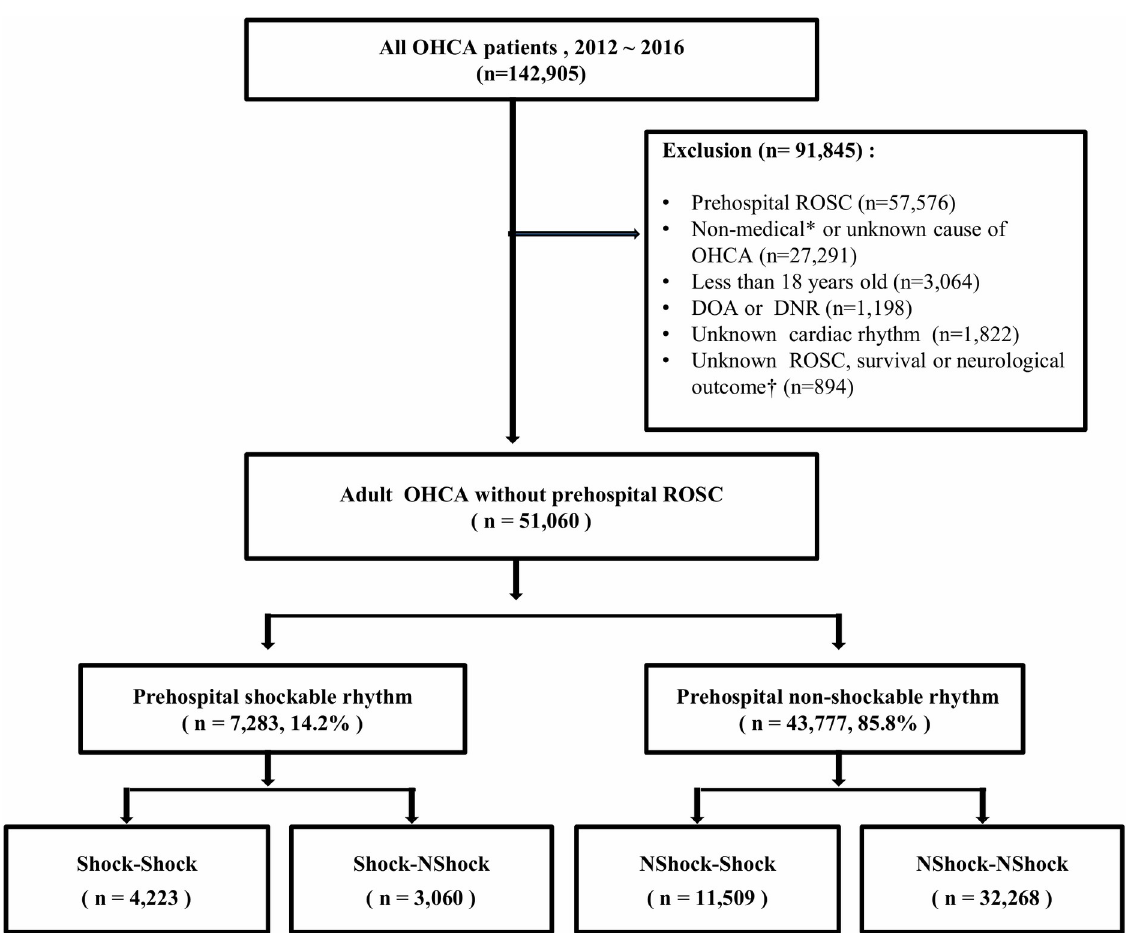
Fig 2. Flow diagram of the studied population. Shock-Shock, shockable and shockable; Shock-NShock, shockable and non-shockable; NShock-Shock, non-shockable and shockable; NShock-NShock, non-shockable and non-shockable; ED, emergency department; OHCA, out- of-hospital cardiac arrest; DOA, dead on arrival; DNR, do not resuscitate; ROSC, return of spontaneous circulation. � non-medical causes included trauma, asphyxia, poisoning, and drowning. †defined as patients with an invalid outcome because of data loss in the medical review or transfer to other